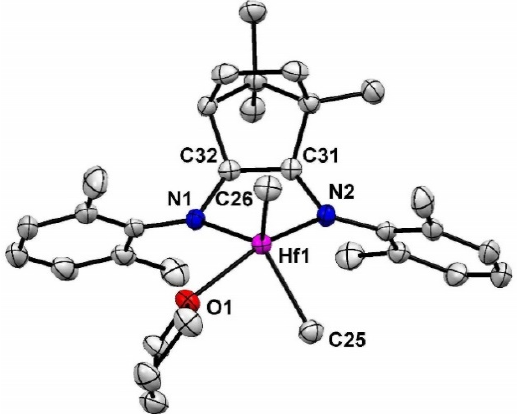
Figure 2. Molecular structure of 1-Hf . Selected distances (Å) and angles (deg): Hf1–N1 2.060(2), Hf1–